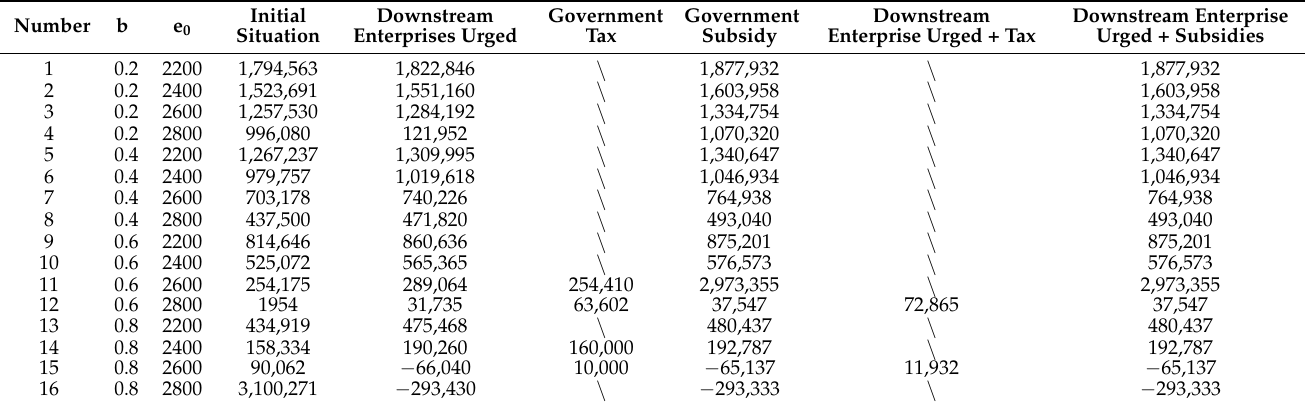
Table 5. Social welfare.